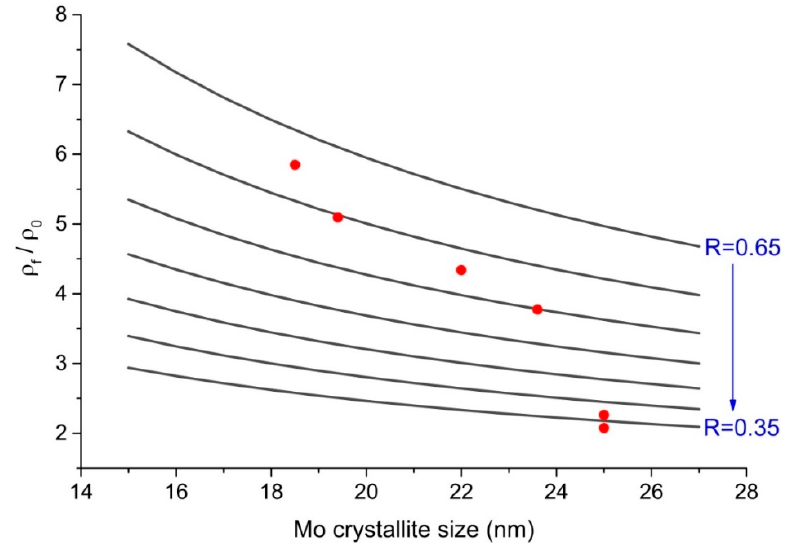
Figure 6. Change of ρ f / ρ 0 as a function of Mo crystallite size. Solid dots are measurement data, and solid curves are calculated using Equations (4) and (5), with R value varies from 0.65 to 0.35, with step of 0.05.